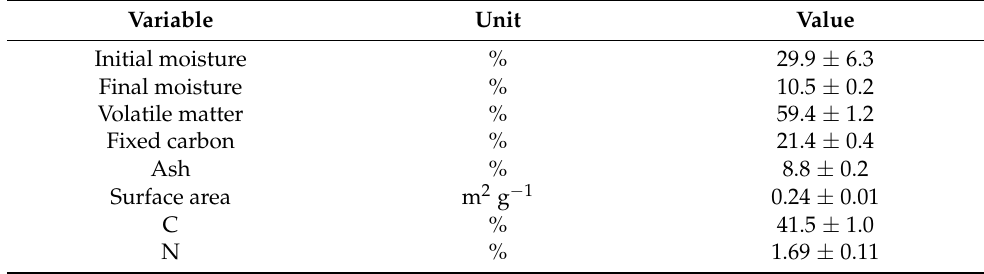
Table 1. Physicochemical characterization of cocoa pod husk